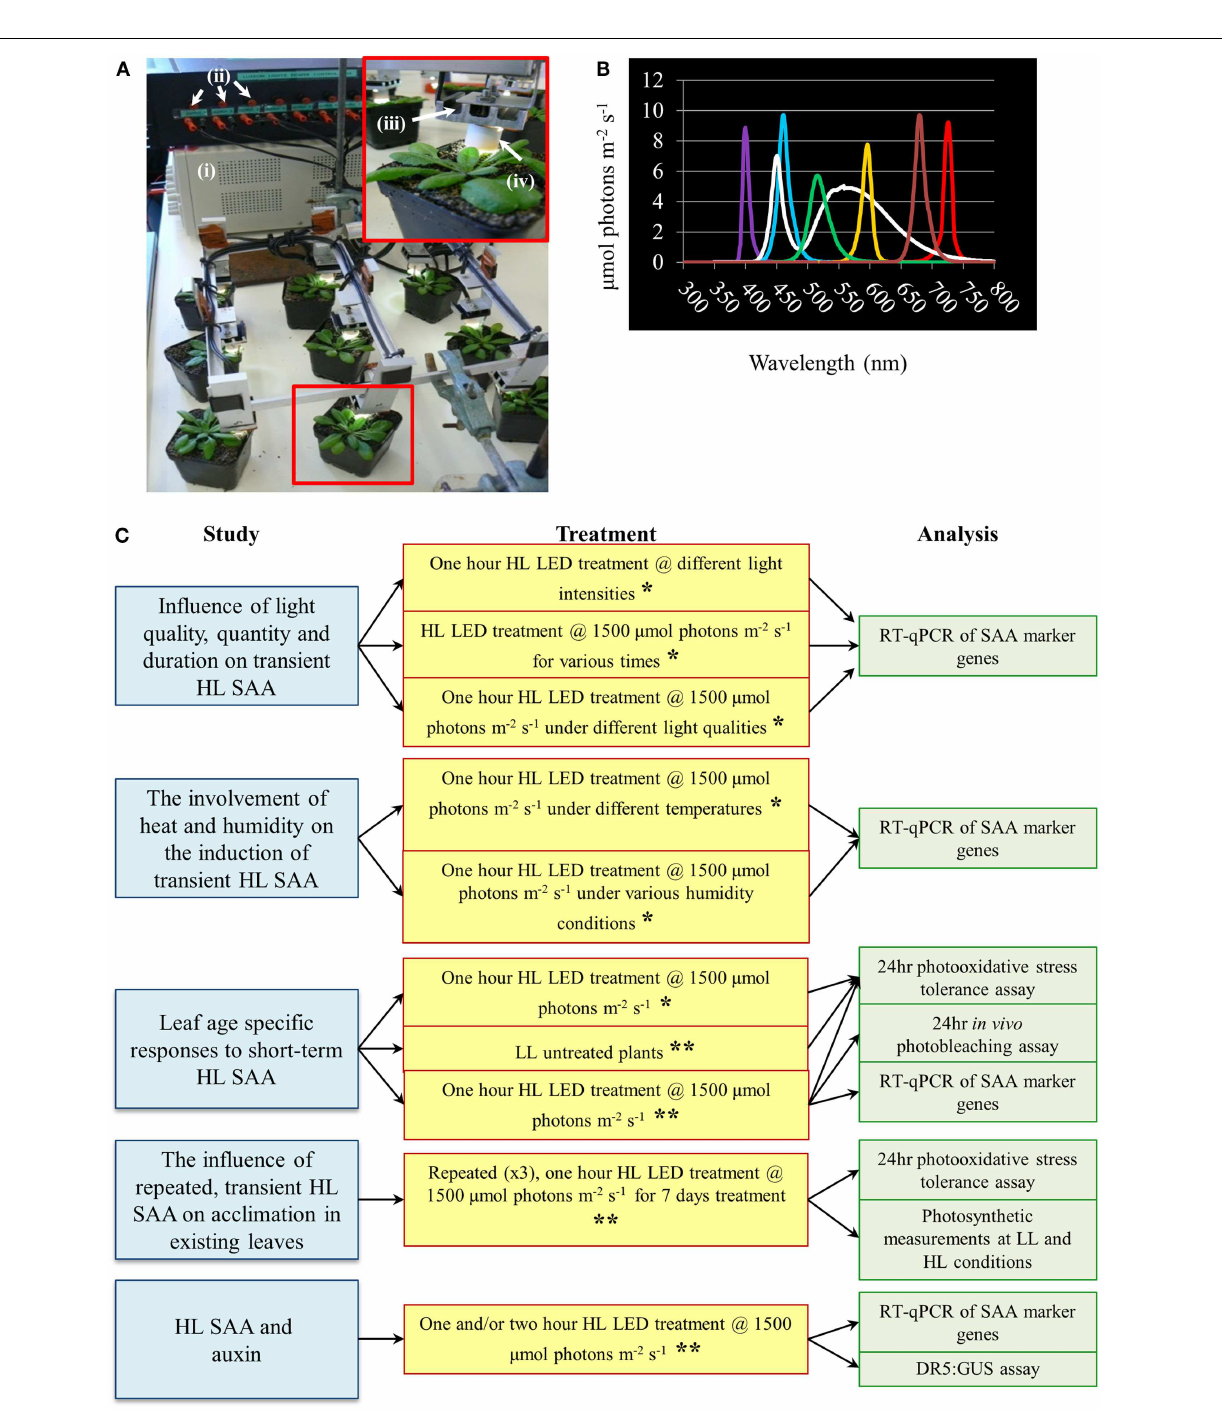
FIGURE 1 | High light systemic acquired acclimation-array, spectral output of specific LEDs and schematic overview of experiments conducted throughout the research article. (A) HL LED-array. Inset depicts a close-up image of a single treated Arabidopsis plant. Components of the HL LED-array include (i) power supply, (ii) current limiters for each LED, (iii) individual movable LED stage with heat sink, and (iv) light focusing lens. (B) Measured irradiance spectra from colored LEDs, n = 3. (C) Schematic